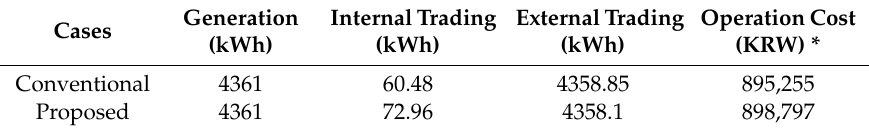
Table 3. Summary of results for the conventional case and the proposed strategy in normal mode.